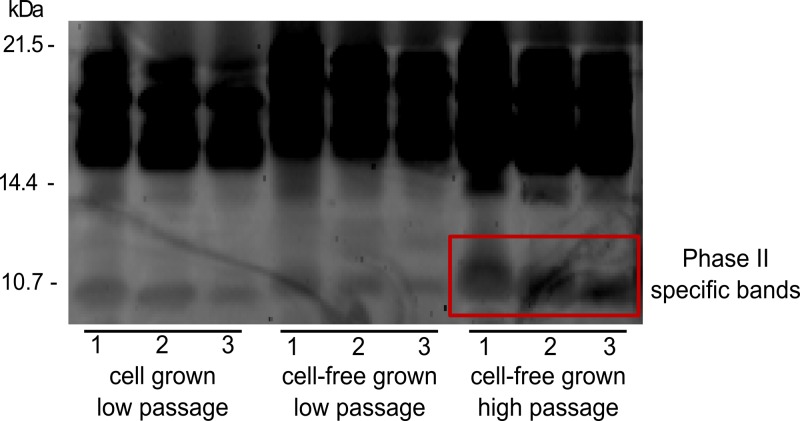
SDS-PAGE of C. burnetii whole cell lysates of low passaged cell-based and cell-free cultures and high passaged cell-free cultured 602 strain.Three serial dilutions (1:5) marked as 1, 2 and 3 for all samples were used. The red box indicates the phase II specific bands seen in high passaged cell-free cultured strain.